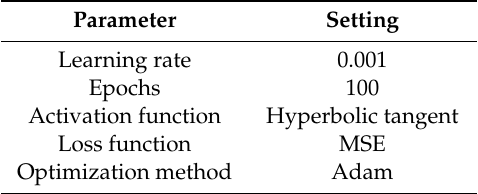
Table 3. Parameter settings of the